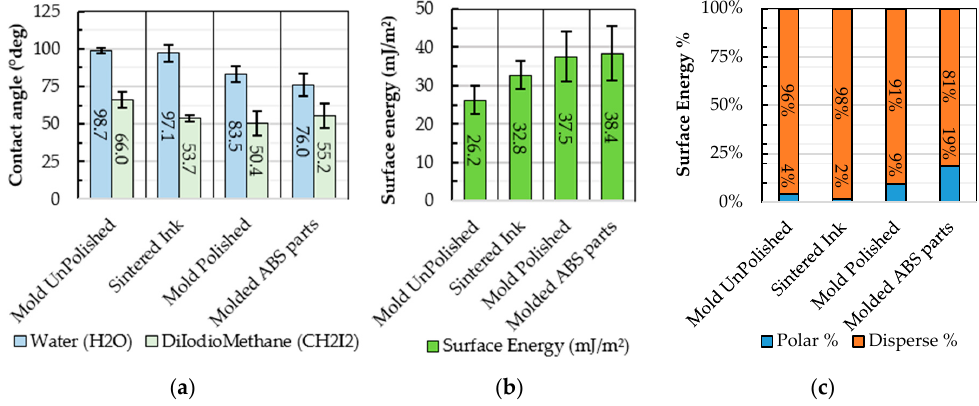
Figure 7. ( a ) Contact angle measurements for polar (H 2 O) and a-polar (CH 2 I 2 ) liquids: ( b ) surface energy for different surfaces; ( c ) percentage of dispersion and polar content for the analyzed surfaces.